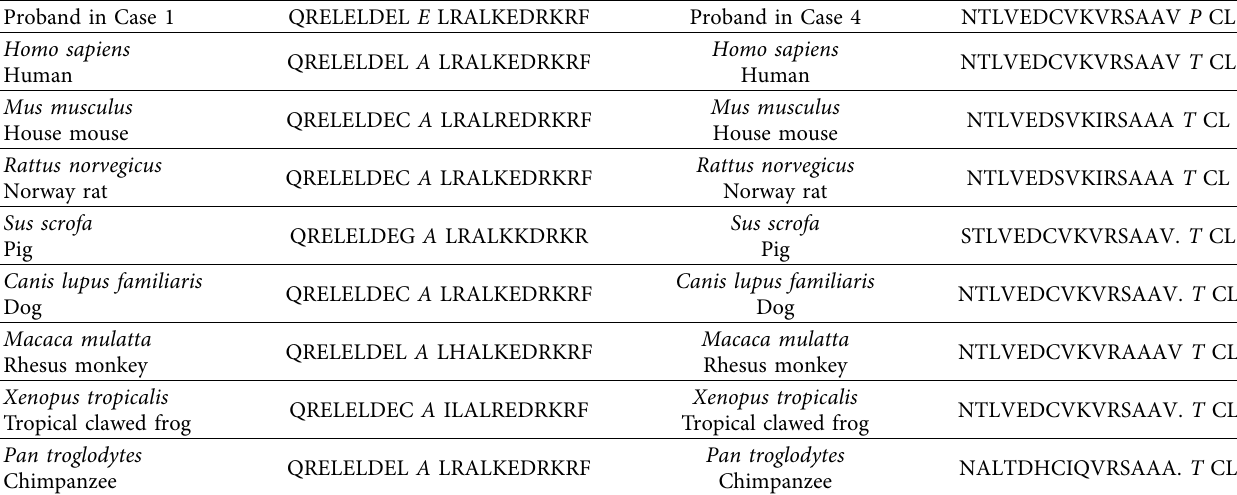
Table 2: Conservation of the mutated domain across species in comparison to Cases 1 and 4.